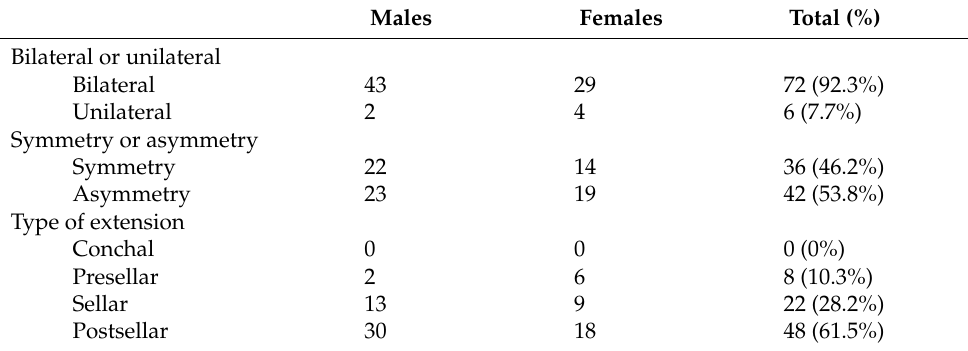
Table 1. Morphological features of the sphenoid